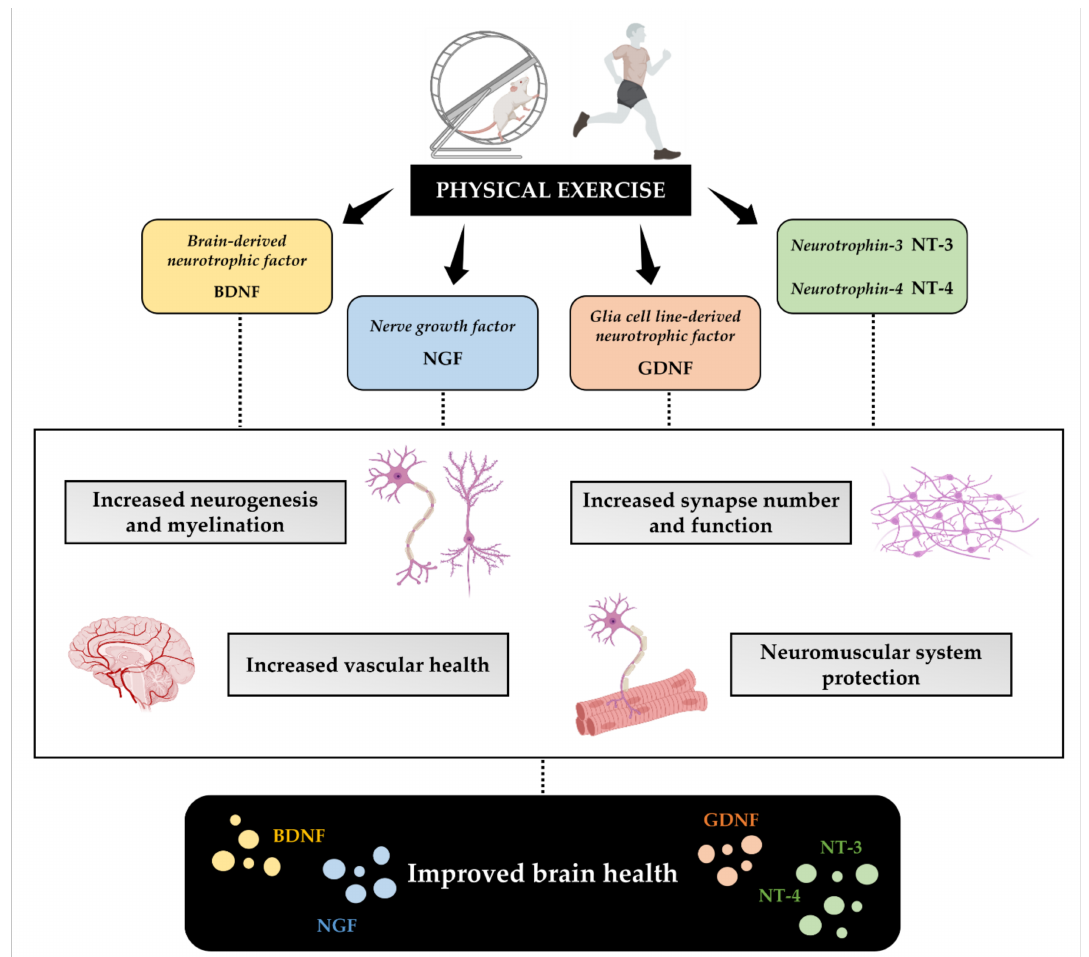
Figure 1. Physical exercise promotes brain health through the production of neurotrophins. Neu- rotrophins are growth factors with a protective role in the central nervous system. Among the most studied are brain-derived neurotrophic factor (BDNF), nerve growth factor (NGF), glial cell line- derived neurotrophic factor (GDNF), neurotrophin-3 (NT-3), and neurotrophin-4 (NT-4), which are re- leased following exercise and promote increased neurogenesis, myelination, and synapse number and function, improve vascular health in the brain, and provide protection to the neuromuscular